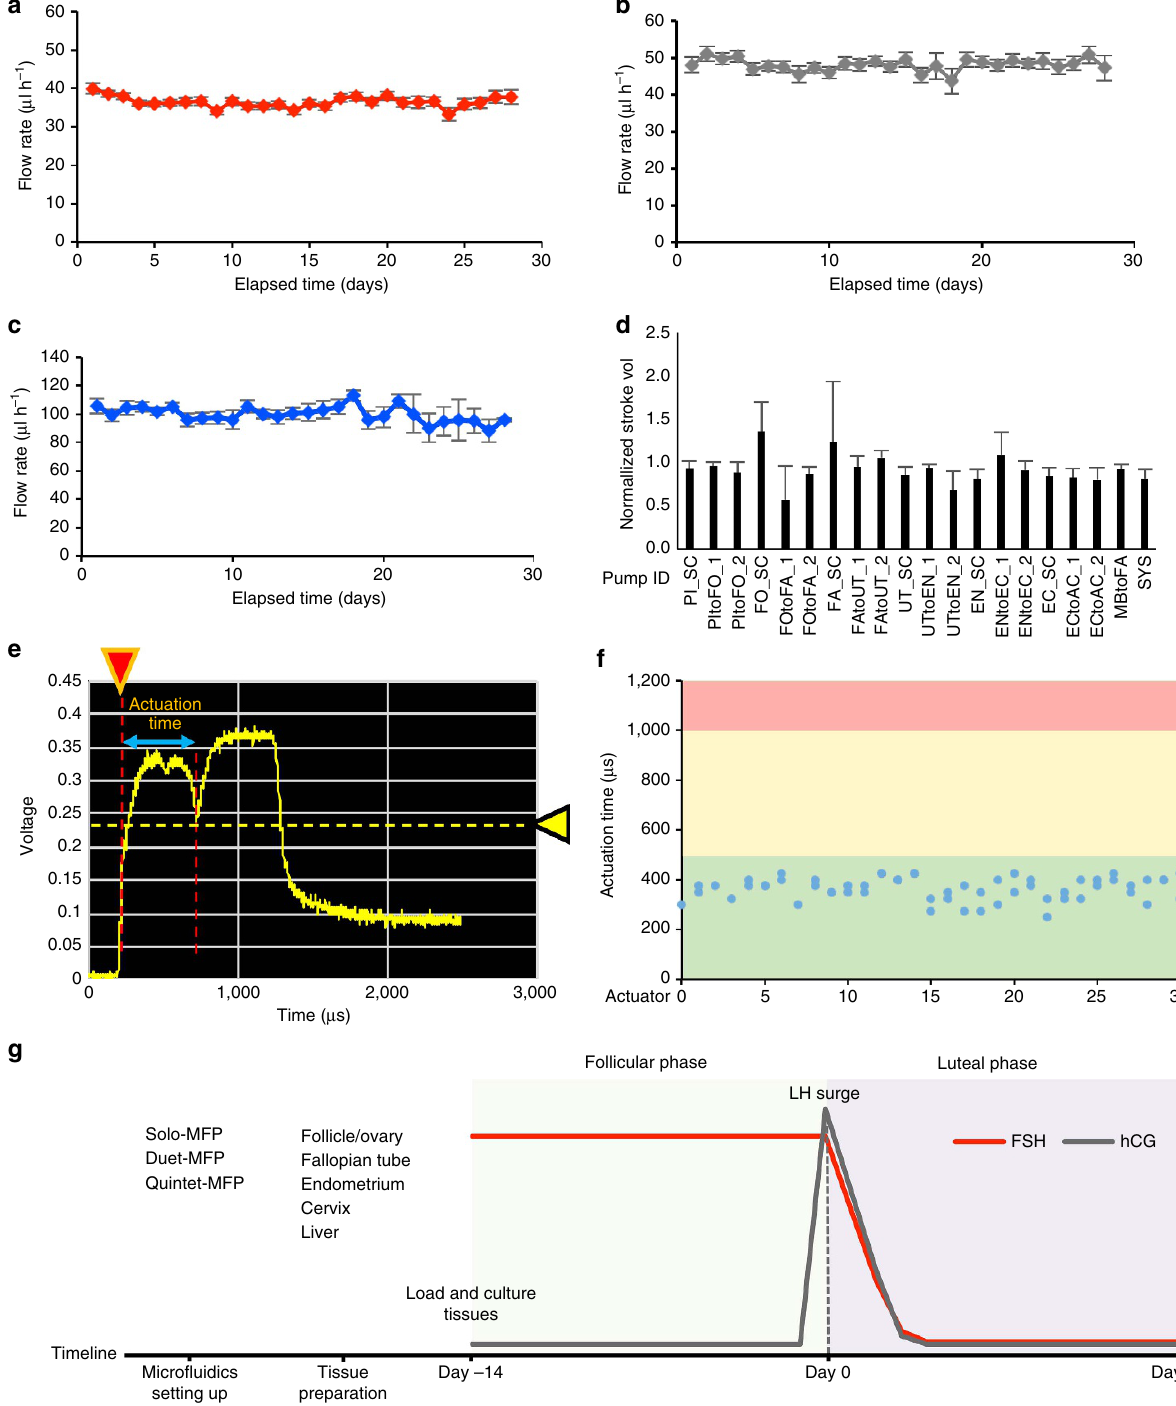
NATURE COMMUNICATIONS|8:14584|DOI: